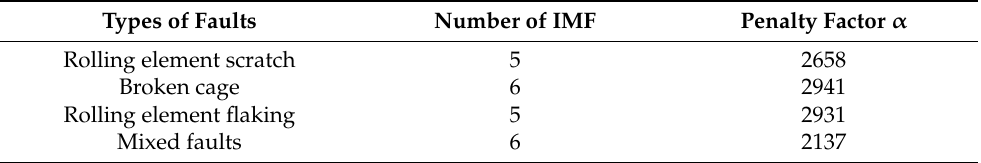
Table 2. Optimized parameters for four types of fault